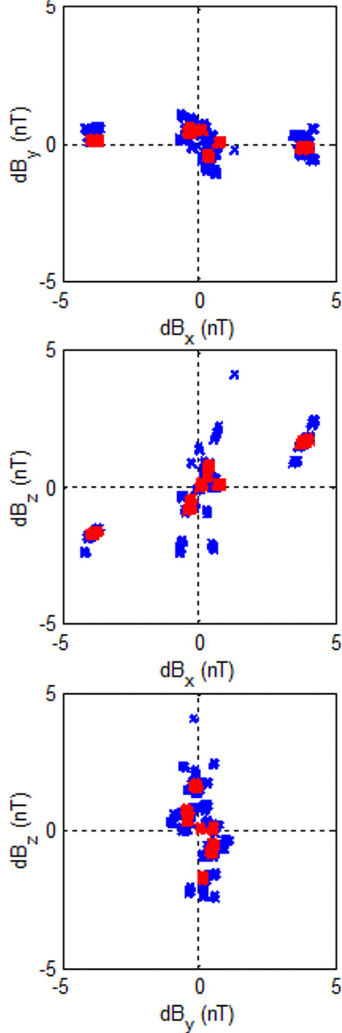
Fig. 4. 2-dimensional projections of the clusters identified from the full 3 components of B D (t) . The red and blue points mark the primary and remaining clusters,